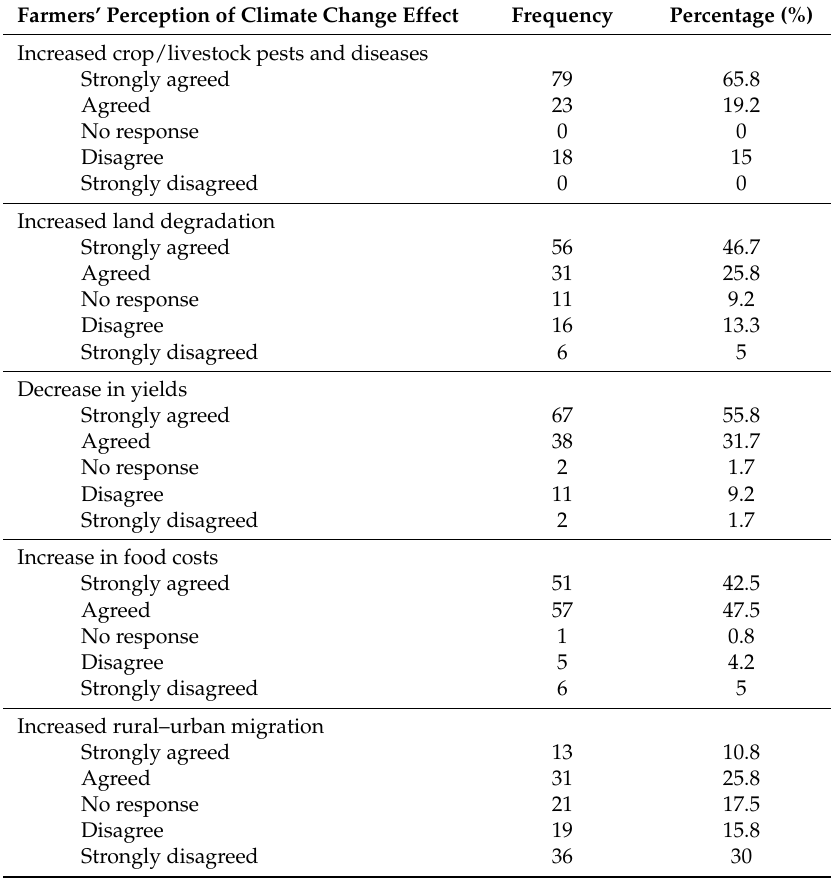
Table 1. Distribution of respondents by perceived effect of climate change ( n =